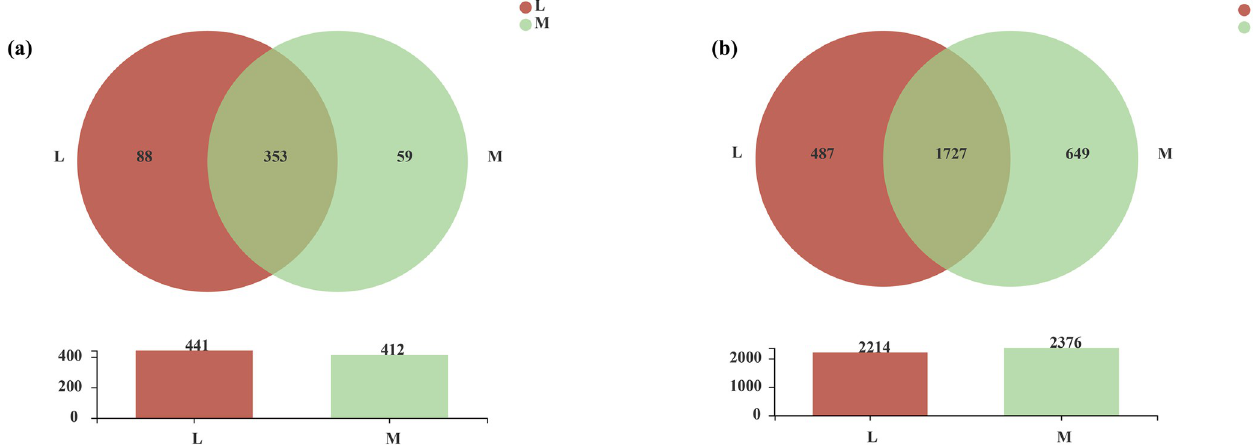
Fig 6. Venn analysis of soil bacteria between moss- (M) and non-moss growth (L) areas at the genus (a) and OTU (b) levels in litchi orchard.